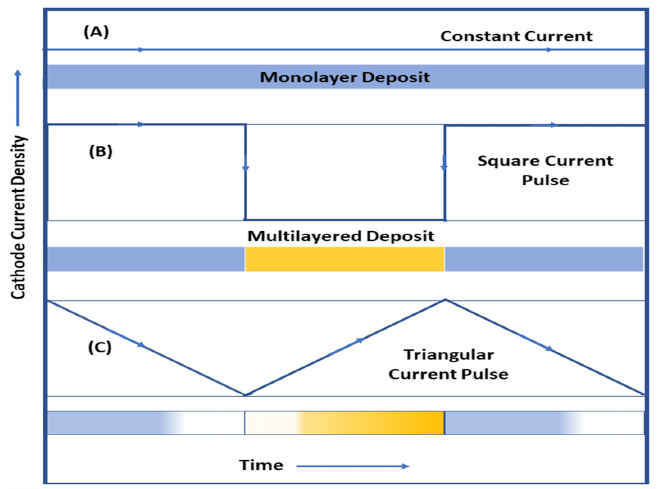
Figure 1. Graphical depiction of waveforms of single-layer ( A ) multilayer using square ( B )and tri- angular current pulses ( C ). triangular current pulses ( C